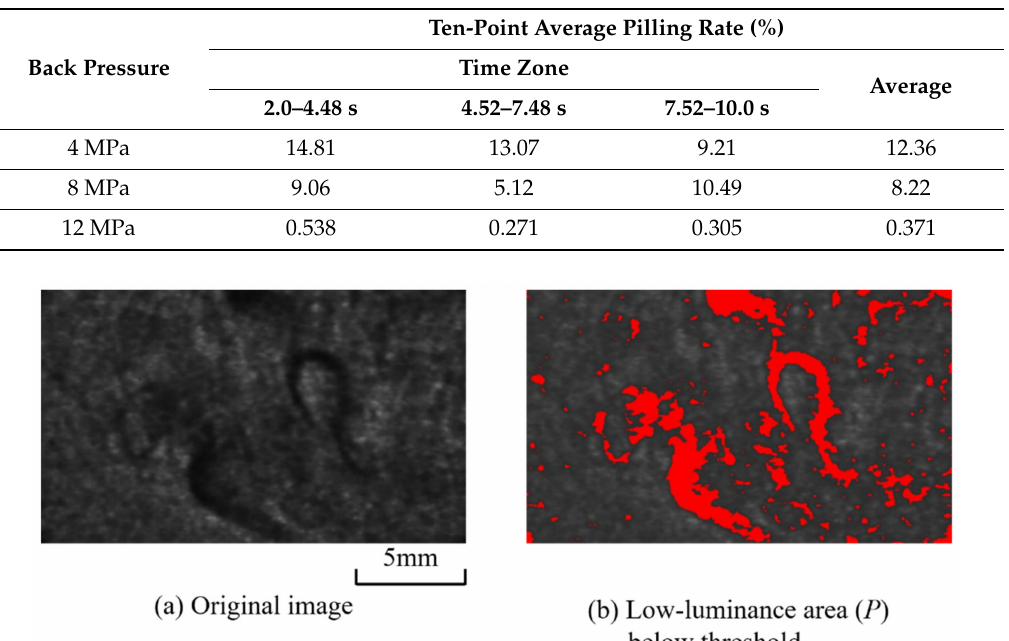
Table 2. Change of pilling rate with elapsed time.